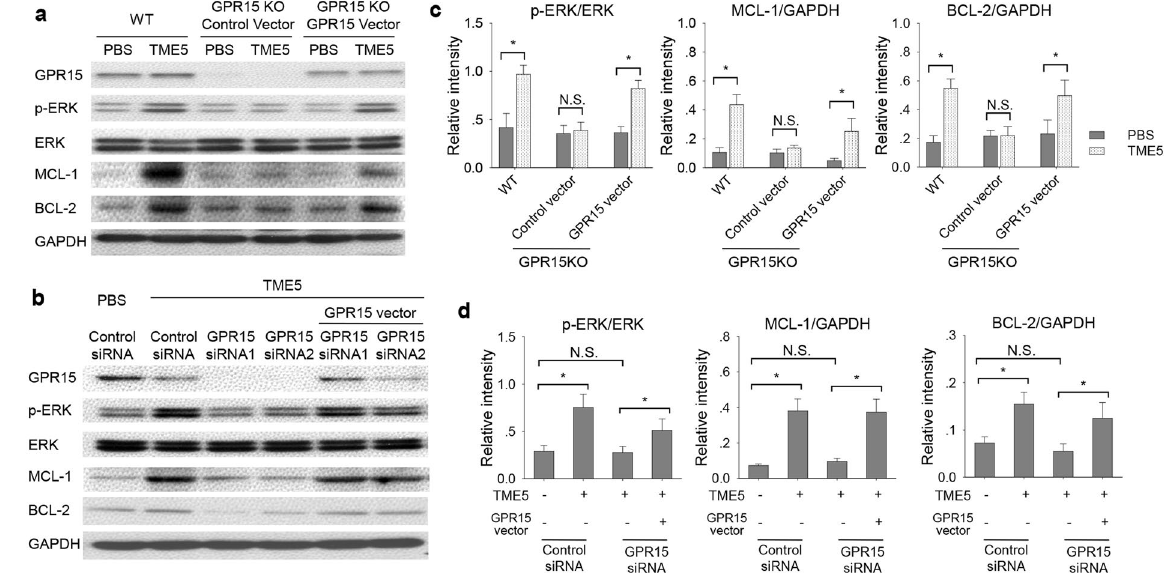
Figure 4. TME5 increases phosphorylation of signal-regulated kinase and level of Bcl-2 in ECs via GPR15. ( a ) Murine ECs from WT or GPR15 KO mice were treated with PBS or TME5 (250 ng/ml) for 48 hrs. In addition, GPR15 KO ECs were transduced with GPR15 expressing lentivirus vector followed by treatment with PBS or TME5 (250 ng/ml). ( b ) HUVECs, transfected with control siRNA or GPR15-specific siRNA, were treated with PBS or TME5 (250 ng/ml) for 48 hrs. For forced expression of GPR15, HUVECs were co-transfected with a GPR15-expression vector. Total proteins extracted from cells were analyzed by western blot. The PVDF membranes were probed with the indicated antibodies in sequence. Figure represents one from three independent experiments. Relative intensities of phospho-ERK, MCL-1 and BCL were analyzed in murine ECs ( c ) and HUVEC ( d ) (n = 3 in each). Data are shown as mean ± SD, and are compared using one-way ANOVA test. * p < 0.05; N.S., no significance.